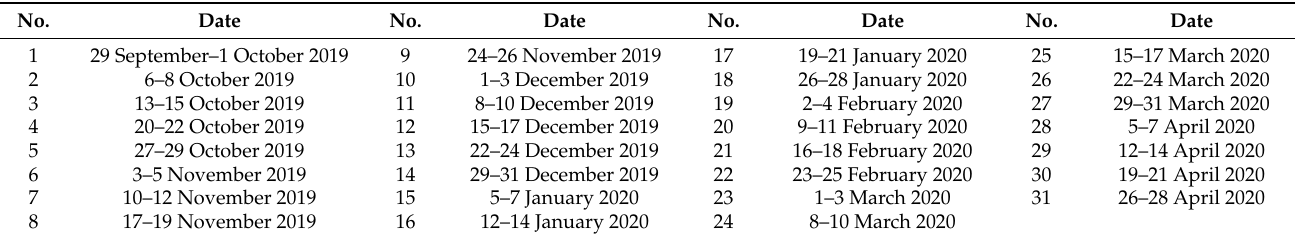
Table 3. Dates of the AARI sea ice charts in the Arctic in the 2019/2020